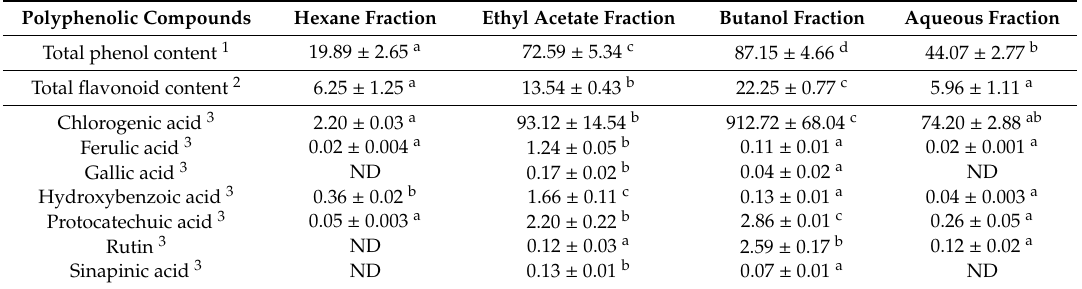
Table 2. Polyphenolic compounds in solvent fractions of Sorbus commixta fruit ethanol extract. Polyphenolic Compounds